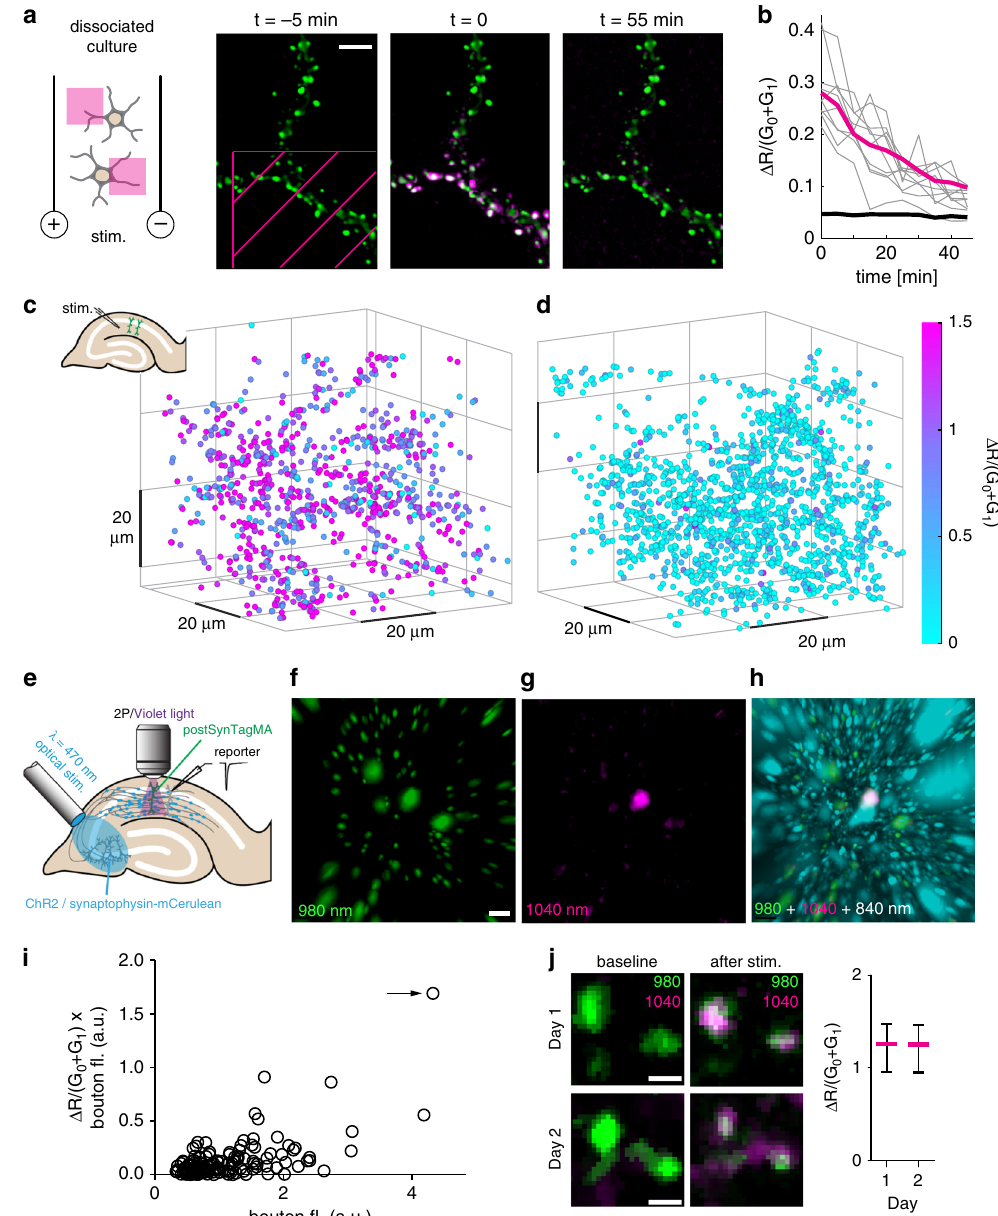
Fig. 6 Using postSynTagMA to map active synapses. a Time series from a postSynTagMA-expressing neuron in culture. At t = 0, one violet light pulse was applied via DMD inside the magenta hatched area (405 nm, 18.6 mW mm − 2 , 0.5 s) while stimulating with a single train of action potentials delivered at 50 Hz for one second. b Inside the illuminated area, red fl uorescence generated by photoconversion of postSynTagMA decayed exponentially with τ = 29.4 min ( R 2 = 0.99, n = 138 synapses, 2 experiments). Gray lines show individual synapses. For objects outside the illuminated square, Δ R/(G 0 + G 1 ) was constant (black line, n = 712 synapses, 2 experiments). c Photoconversion after Schaffer collateral stimulation in organotypic slice culture. Color-coded Δ R/(G 0 + G 1 ) of synapses plotted at their locations in the 65 × 65 × 78 µ m volume of tissue. Strong stimulation of synaptic inputs was paired with violet light (100 ms, 395 nm, 16 mW mm − 2 , 50 repeats). Note that Δ R/(G 0 + G 1 ) is equal or greater than 1.5 for most of the synapses ( n = 897 synapses). d As in c , but with weak stimulation, below the threshold for postsynaptic APs ( n = 1502 synapses). e CA3 neurons expressing ChR2-ET/TC and synaptophysin-mCerulean were stimulated with 470 nm fl ashes to evoke subthreshold (~500 pA) excitatory synaptic responses in a patch-clamped CA1 neuron (reporter). Simultaneously, an adjacent postSyntagMA-expressing CA1 neuron was illuminated with violet light (same illumination as c – d ). f Green spots (G 0 + G 1 ) segmented with Imaris ™ . g Red fl uorescence after photoconversion (R1), masked by the green channel. Note the strongly photoconverted synapse (spot #1). h Spot #1 (magenta) is in close contact with a presynaptic ChR2-expressing terminal (cyan). Non-converted (green) spots are not in direct contact with cyan terminals. i Quanti fi cation of panels f – h ( n = 167 spots). Arrow indicates spot #1. j Red/green overlay before and after photoconversion of the same synapses on successive days. Strong extracellular stimulation was paired with 395 nm light (500 ms, 1 s delay, 15×). Photoconversion of postSynTagMA was near-identical on day 1 and day 2 ( p = 0.386, paired two-tailed t -test, n = 37 synapses, data presented as median ± interquartile range). All experiments were reproduced in at least twice independent experiments. Scale bars: 5 µ m ( a ), 3 µ m ( f – h ), 1 µ m ( j